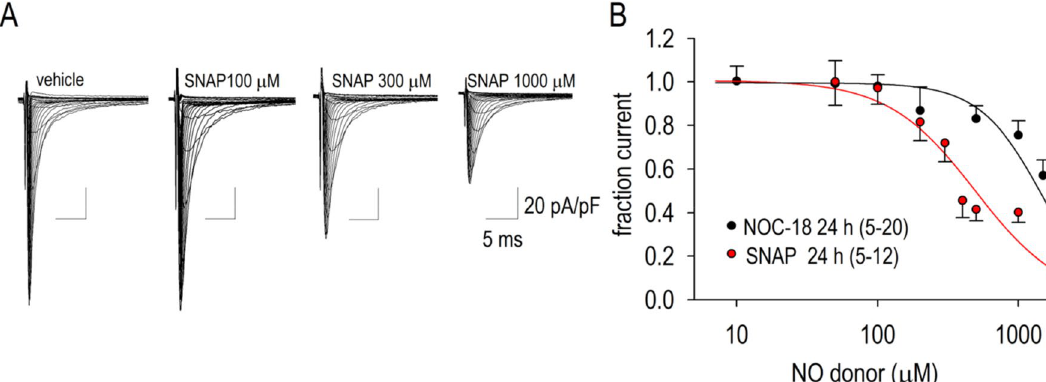
Figure 2. Concentration-dependent long-term (24 h) effects of NOC-18 and S-Nitroso-N-acetyl-DL- penicillamine (SNAP) on I Na . ( A ) Representative I Na traces with vehicle, 100 μM SNAP, 300 μM SNAP and 1000 μM SNAP applied for 24 h. ( B ) Dose–response relationships of the effects of NO donors, NOC-18 and SNAP, on the fractional I Na . The potency, e.g. half-maximum inhibitory concentration (IC 50 ), was estimated as 491 μM and 1505 μM for SNAP and NOC-18, respectively. Numbers of cell are shown in